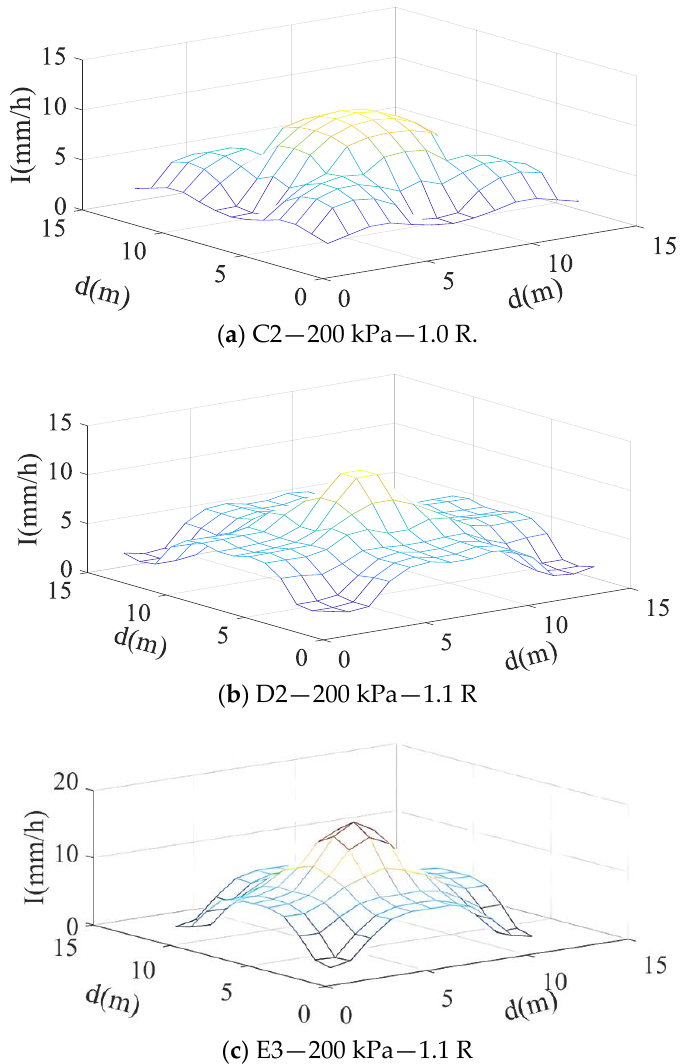
Figure 10. 3D water distribution under combined sprinkler irrigation. (C2 refers to the circular nozzle with a diameter of 5 mm; D2 refers to the diamond nozzle with an aspect ratio of 1.32; E3 refers to the elliptic nozzle with an aspect ratio of 2.58).